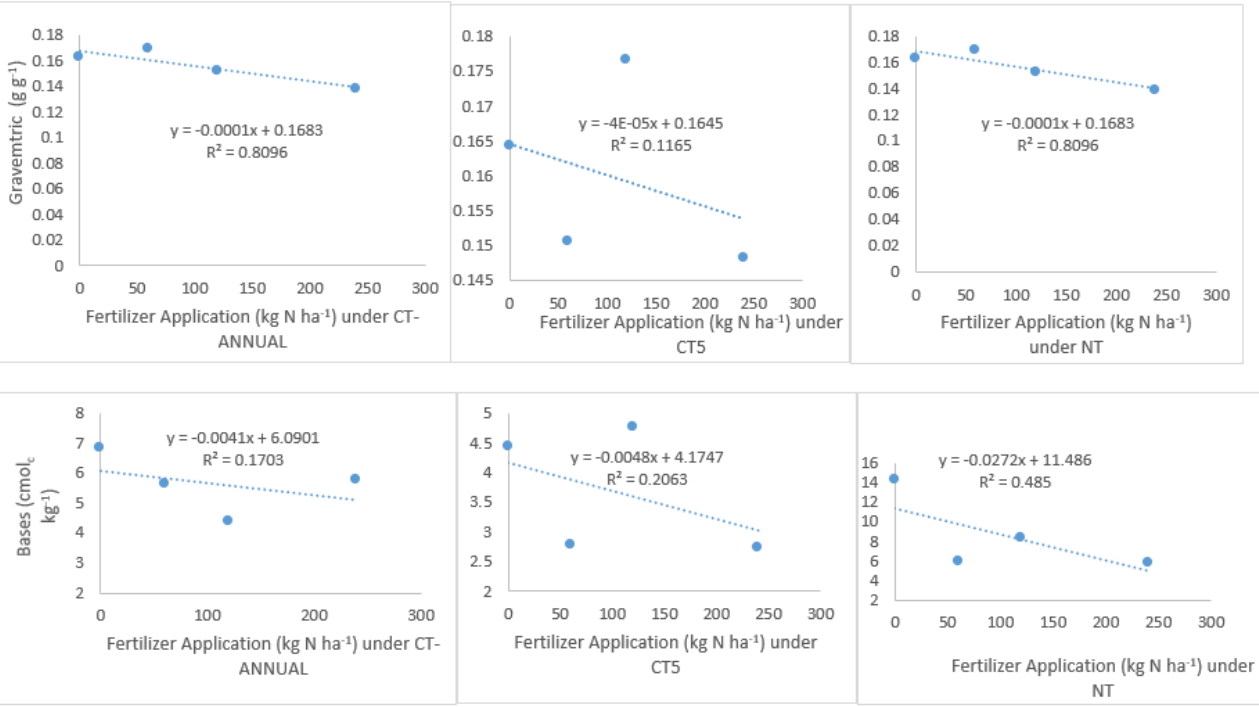
Figure 1. Relationship between fertilizer application rates under different tillage techniques and gravimetric water content and bases.